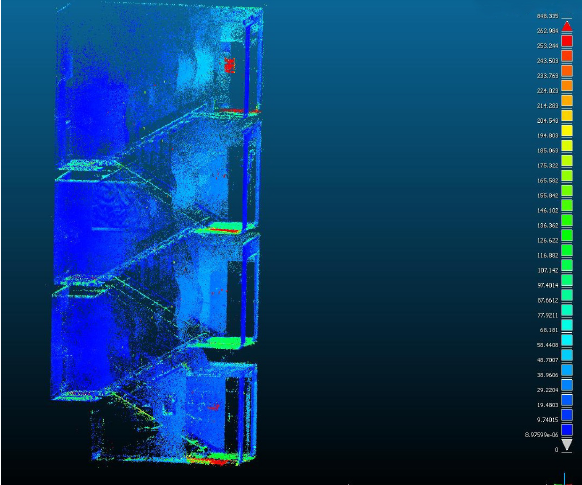
Figure 4: Distance comparison between the sparse IBM point cloud and the TLS point